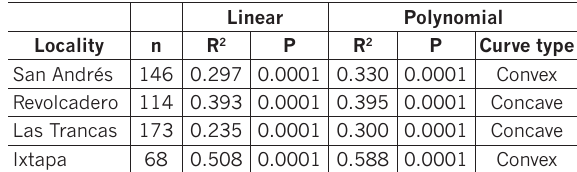
Table 3. Results of the regression analysis used to evaluate the relationship between number of cysts of Microphallus nicolli (log x+1) per crab and the cephalothorax length of crabs from four coastal locations in Guerrero, Mexico. n = number of crabs that were examined; R 2 = coefficient of determination; P = sig - nificance level. Note: 100% of the crabs examined were